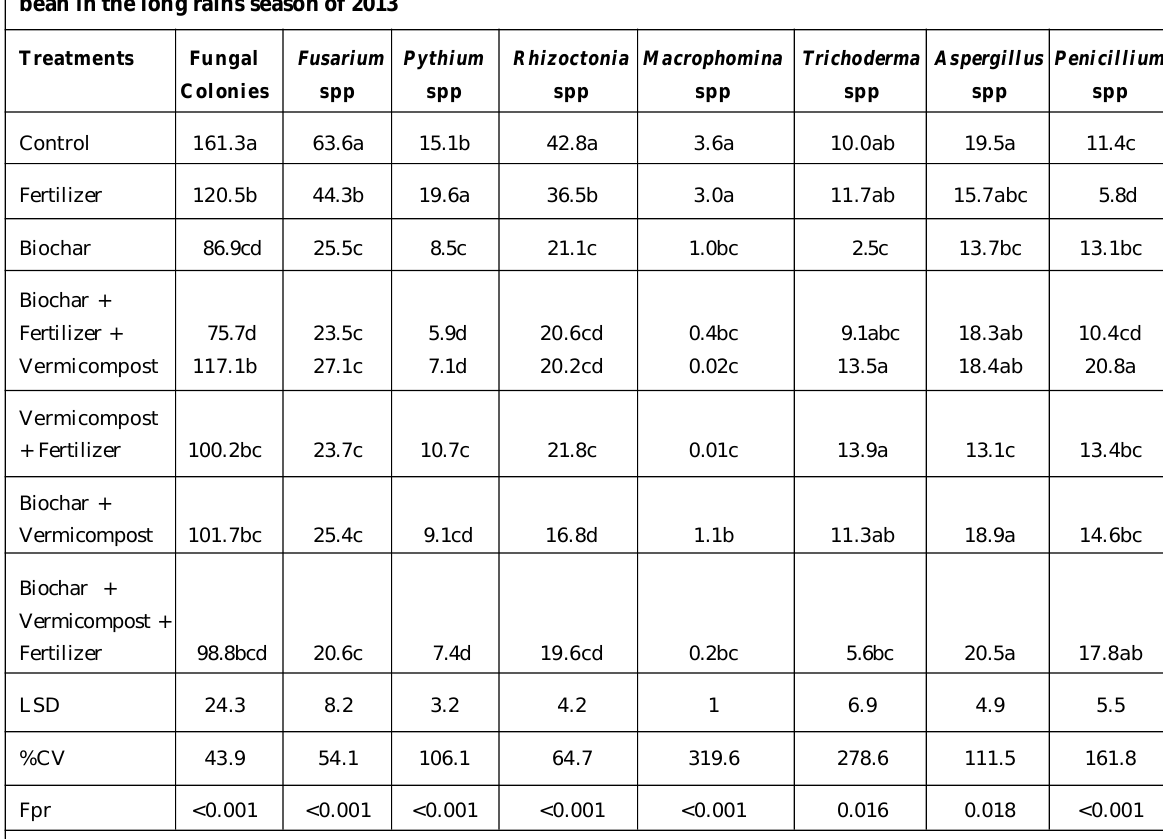
Table 9: Effect of biochar and vermicompost on fungal populations ( × 10 3 CFU/g soil) at harvest of common bean in the long rains season of 2013 Treatments